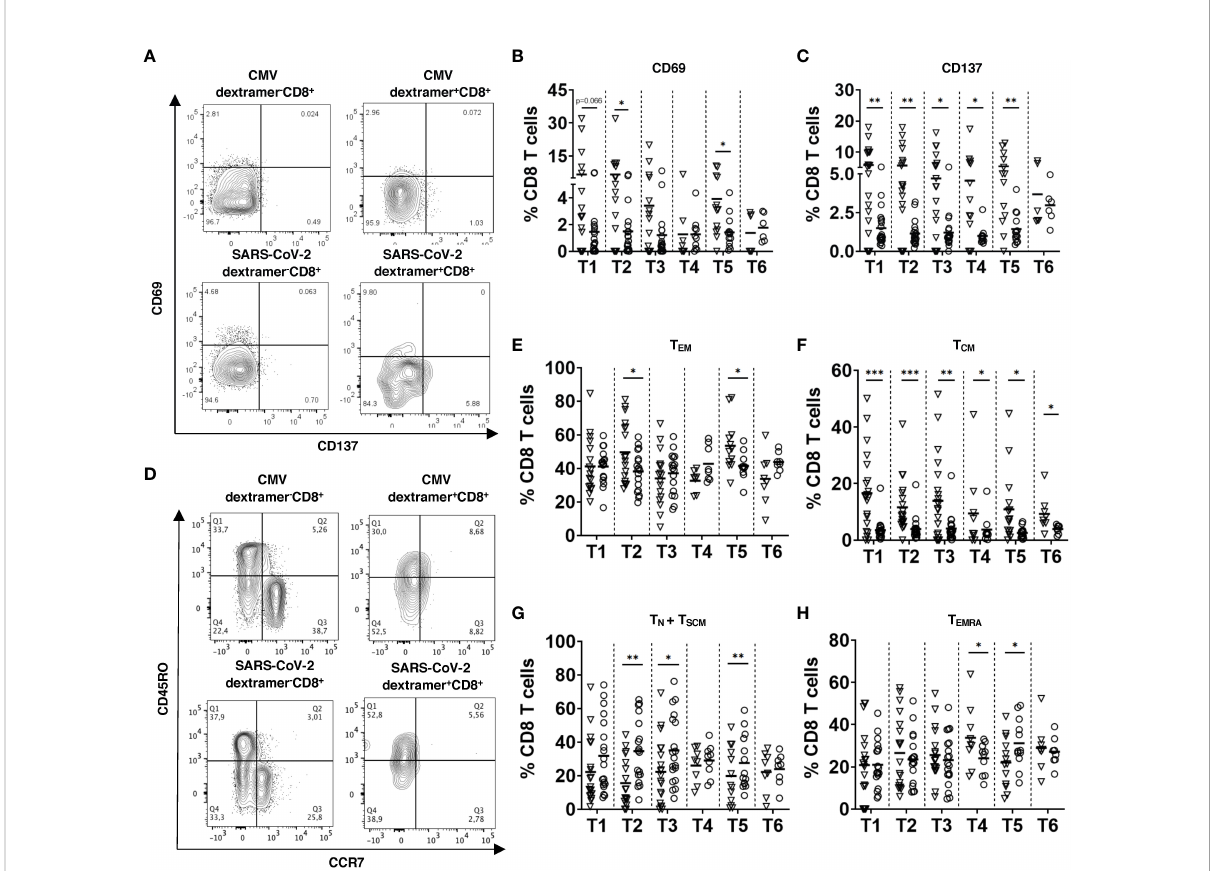
FIGURE 3 Activation status and memory phenotype of SARS-CoV-2 speci fi c CD8 T cells. PBMC (2x10 6 ) were stained with respective SARS-CoV-2 spike or CMV MHC I dextramers and mAbs for CD3, CD4, CD8, CD69, CD137, CD45RO, and CCR7 followed by FACS analysis. (A) Representative dot plots for CD69 and CD137 expression on CMV or SARS-CoV-2 dextramer + CD8 + and dextramer - CD8 + T cells 2 weeks after the 3 rd dose (T5). CD69 (B) and CD137 (C) expression on SARS-CoV-2 dextramer + CD8 + and dextramer - CD8 + T cells from vaccinated individuals (n=19) is presented as the frequency of CD69 + or CD137 + cells within the CD8 T cell subset. (D) Representative dot plots for CD45RO and CCR7 expression on dextramer + CD8 + and dextramer - CD8 + T cells at T5. (E-H) Results for CD45RO + CCR7 - effector memory (T EM , E), CD45RO + CCR7 + central memory (T CM , F), CD45RO - CCR7 + naive and stem cell memory (T N + T SCM , G) and CD45RO - CCR7 - terminally differentiated memory T cells (T EMRA , H) from vaccinated participants (n=19) are shown as the percentage of corresponding subsets among dextramer + CD8 + or dextramer - CD8 + T cells. Data for dextramer + CD8 + and dextramer - CD8 + T cells are shown as inverted triangles and circles respectively. Data were excluded when event count <20 in Dextramer + CD8 + cells. *P<0.05, **P<0.01,